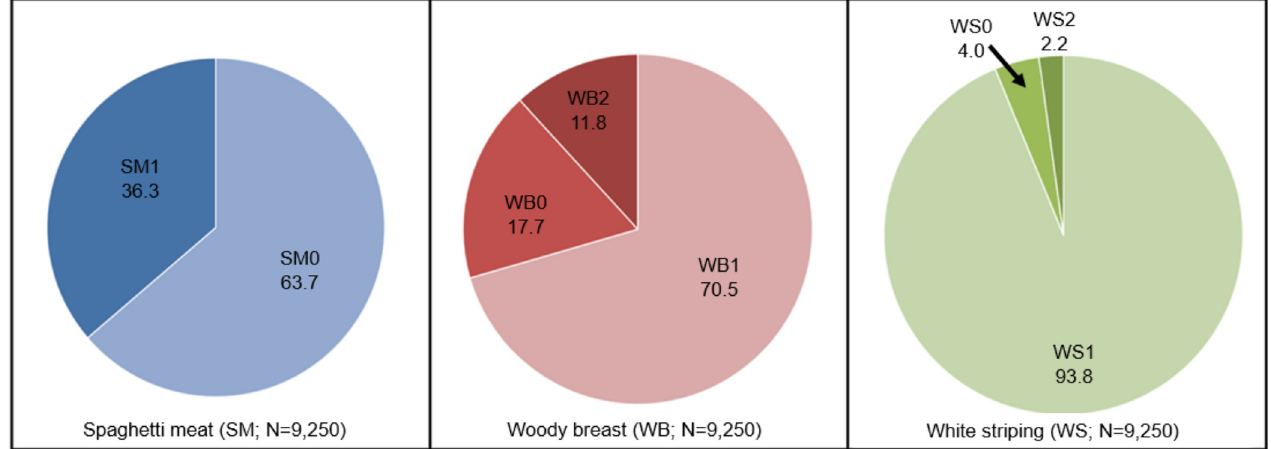
Fig 1. Pie charts illustrating the prevalence of spaghetti meat (SM), woody breast (WB), and white striping (WS). The prevalence of SM (SM1) was 36.3%. The prevalence of moderate WB (WB1) was 70.5%, and the prevalence of severe WB (WB2) was 11.8%. The prevalence of mild WS (WS1) was 93.8%, and the prevalence of moderate WS (WS2) was 2.2%. There was no severe WS (WS3) observed in our samples (n = 9,250; average live weight at slaughter: 2.36 kg).